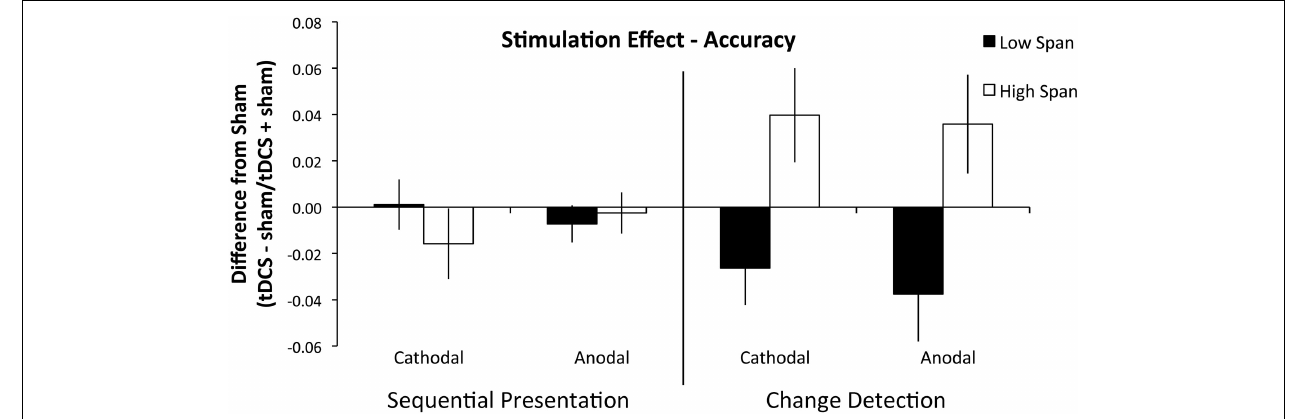
the left and the change detection task on the right.The lowWM span group is plotted in black and the highWM span group is plotted in white. Error bars represent the SEM.There was a significant between-group effect of tDCS across stimulation condition andWM